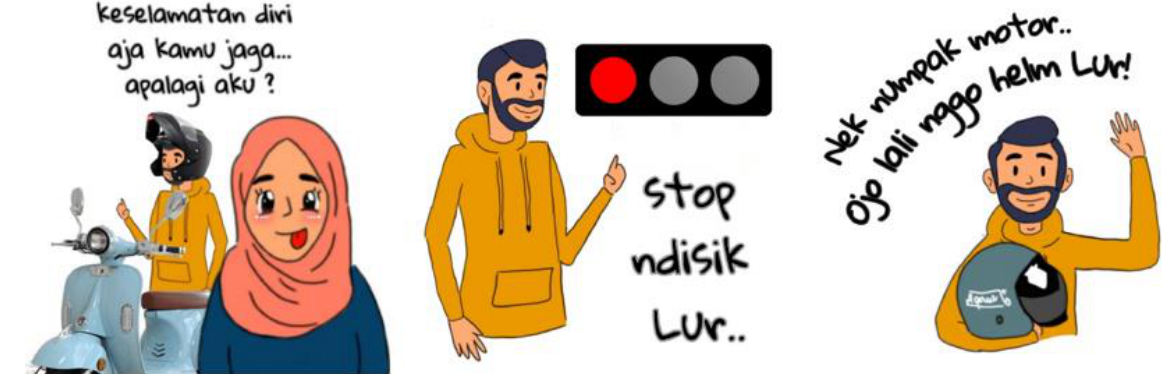
Figure 2. WhatsApp stickers in the Zainafree ’ s RSE Program .